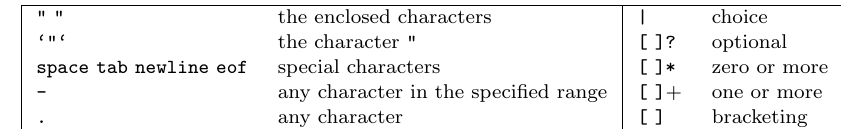
Fig. 2. Automath concrete syntax.